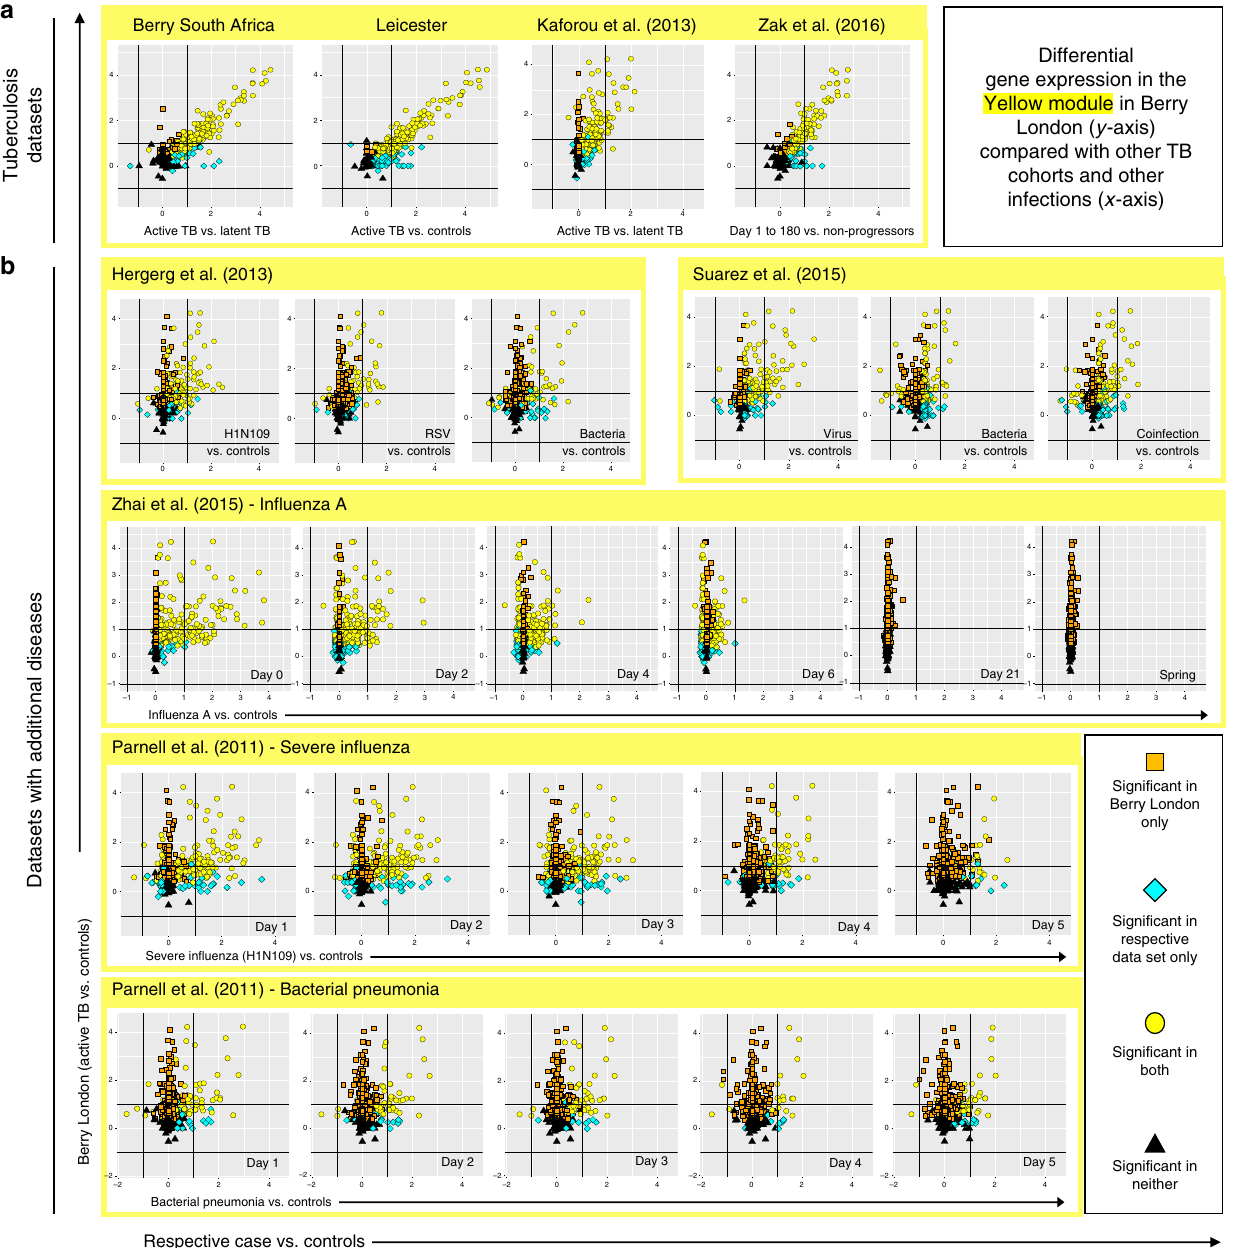
Fig. 5 Gene expression in the yellow module in TB compared to TB cohorts and to other viral and bacterial infections. a Log 2 -fold changes for genes in the yellow module from Berry London cohort (active TB vs. controls; y -axis) compared to the log 2 -fold changes in other datasets (respective cases vs. controls; x -axis) in TB and b other infections (Herberg et al. 38 , Suarez et al. 39 , time-course data from Zhai et al. 36 (in fl uenza A) and Parnell et al. 35 (severe in fl uenza and bacterial pneumonia)). Shapes and colours represent signi fi cantly differentially expressed genes (FDR p -value < 0.05) in either Berry London only (orange squares), respective dataset only (cyan diamonds), both dataset (yellow circles) or signi fi cant in neither (black